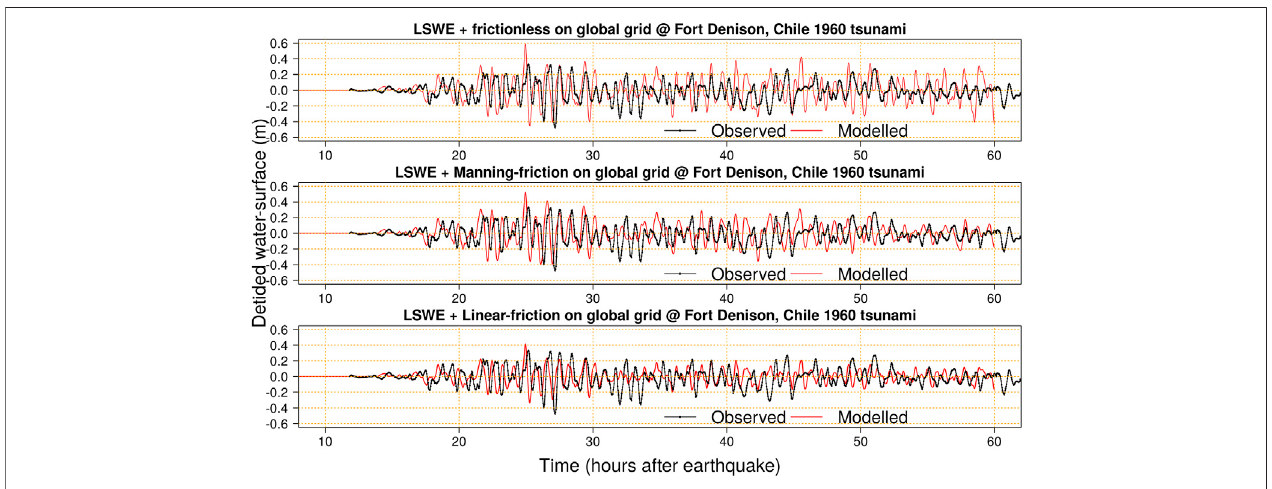
FIGURE7| SimulationsandobservationsoftheChile1960tsunamiatFortDenisonnearSydney.AllsimulationsusetheChile1960H19sourcemodel.Top:Using the frictionless LSWE on the global grid. Middle: Using LSWE with Manning-friction on the global grid. Bottom: Using LSWE with linear-friction on the global grid.